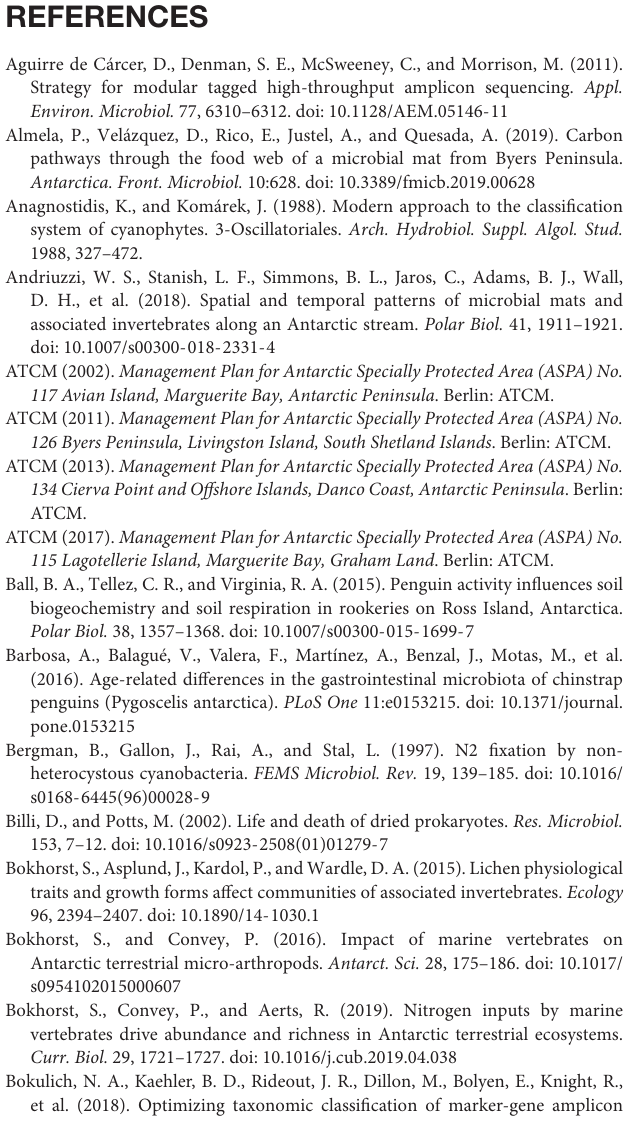
Supplementary Figure 2 | Light microscopy and fluorescence micrographs of the main primary produces and consumers within the food webs. (A)